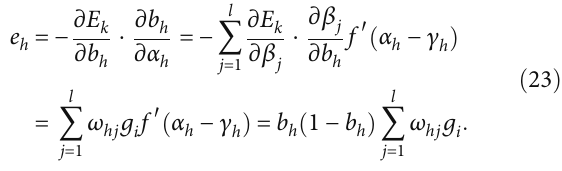
Figure 7: Curve of loss reduction with iteration times under di ff erent